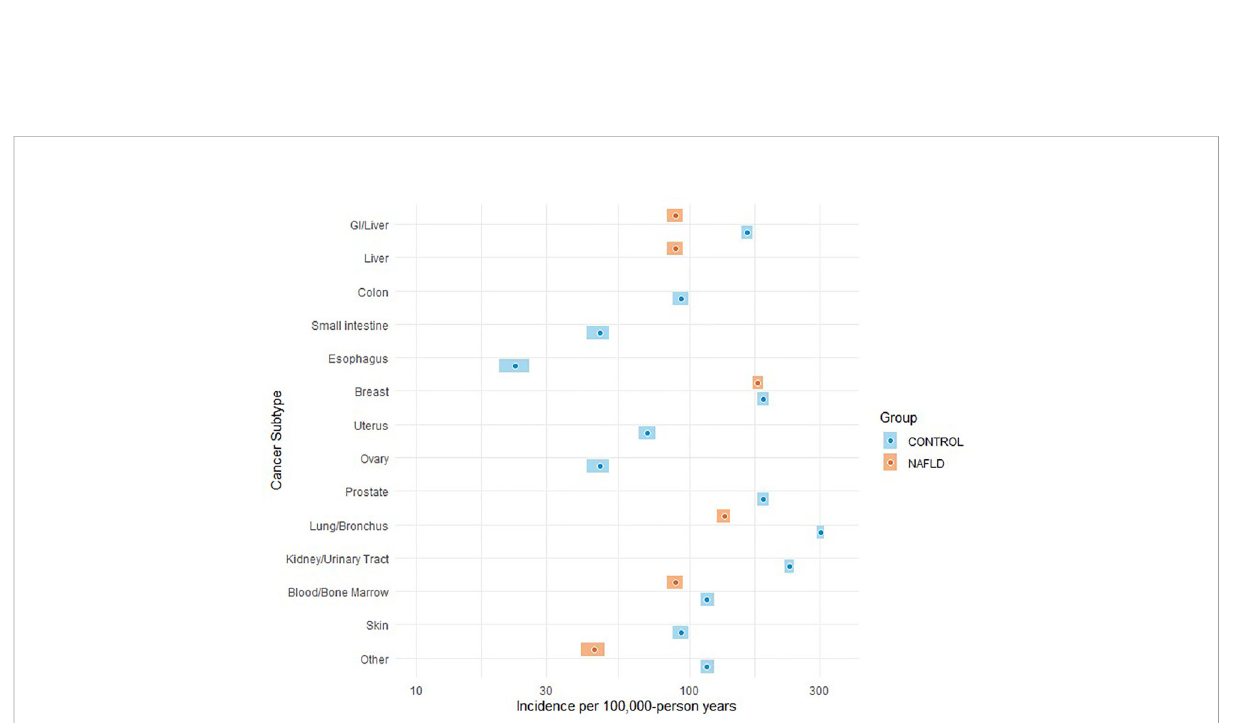
FIGURE 2 Plot chart showing the cancer incidence among individuals with NAFLD compared to age-, sex-, race-, BMI-, and diabetes-matched controls.